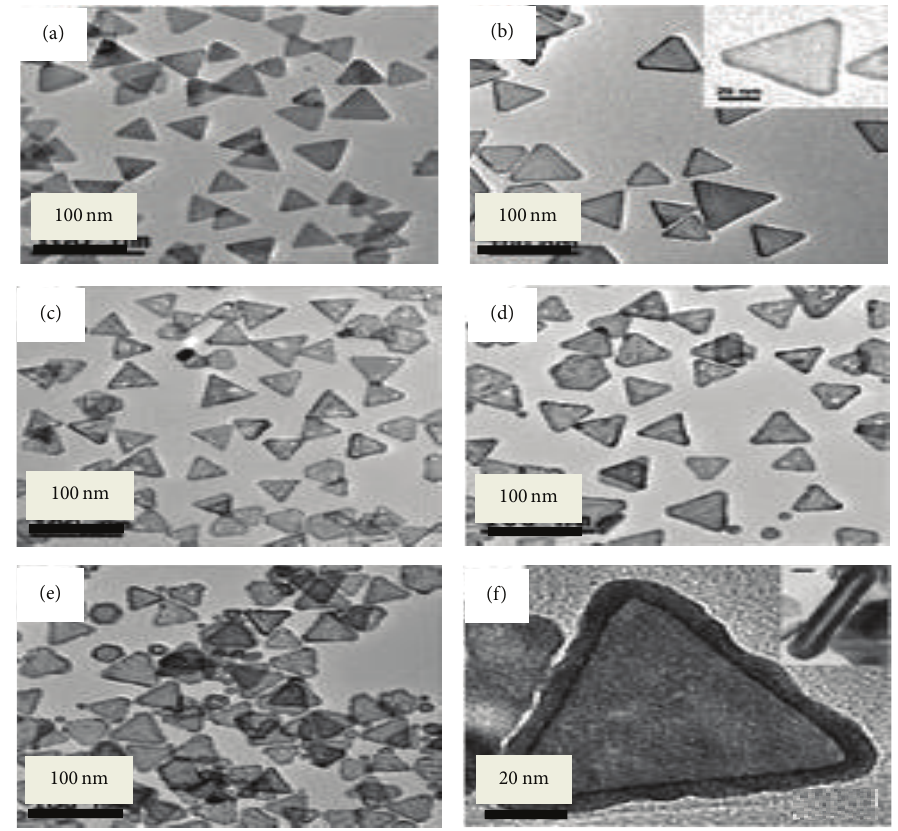
Figure 3: TEM images of (a) initial silver nanoprisms; (b) samples at 45 min with gold deposition on the prism edges; (c) samples from stage 2 with some small pinholes; (d) samples with partially refilled pinholes after 120 min (stage 3); (e) samples at 200 min with full gold shells (stage 4); (f) a typical final gold-coated nanoprism (the inset is the cross-sectional view with a scale bar of 10nm). Reproduce from Shahjamali et al. with permission from wily publisher